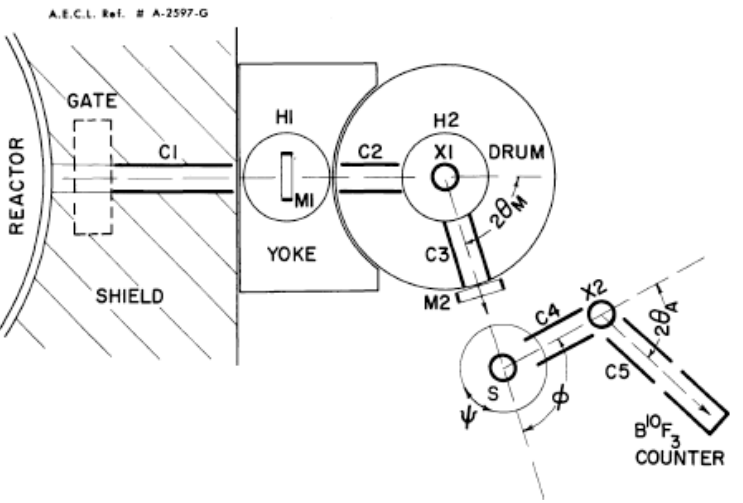
Figure 17. Schematic diagram of the C5 triple-axis crystal spectrometer showing the monochromator scattering angle, 2 θ m , sample angle, Ψ , scattering angle, Φ , and analyzer angle, 2 θ a . The analyzer angle is generally held fixed, and the incident energy varied. A monitor in the incident monochromatic beam with a 1/v response compensates for the k ′ /k factor in the cross-section, so the measurement almost gives S( Q , ω ) directly. The collimator C 2 is placed within the drum before the monochromator, C 3 lies between the monochromator and the sample, and C 4 is placed between the sample and the analyzer. This figure is taken from Figure 4 of ref. [41] courtesy of the IAEA.